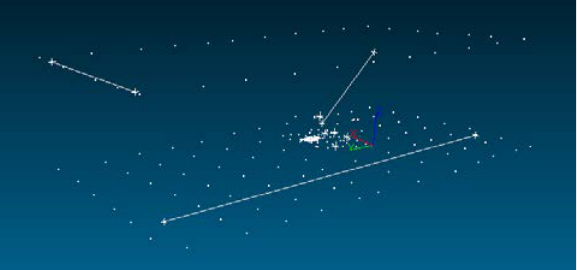
Figure 11. Coded targets in a 50x50 cm grid and scales for the simultaneous camera calibration. The origin of the measured system is defined in one corner of the reference probe.